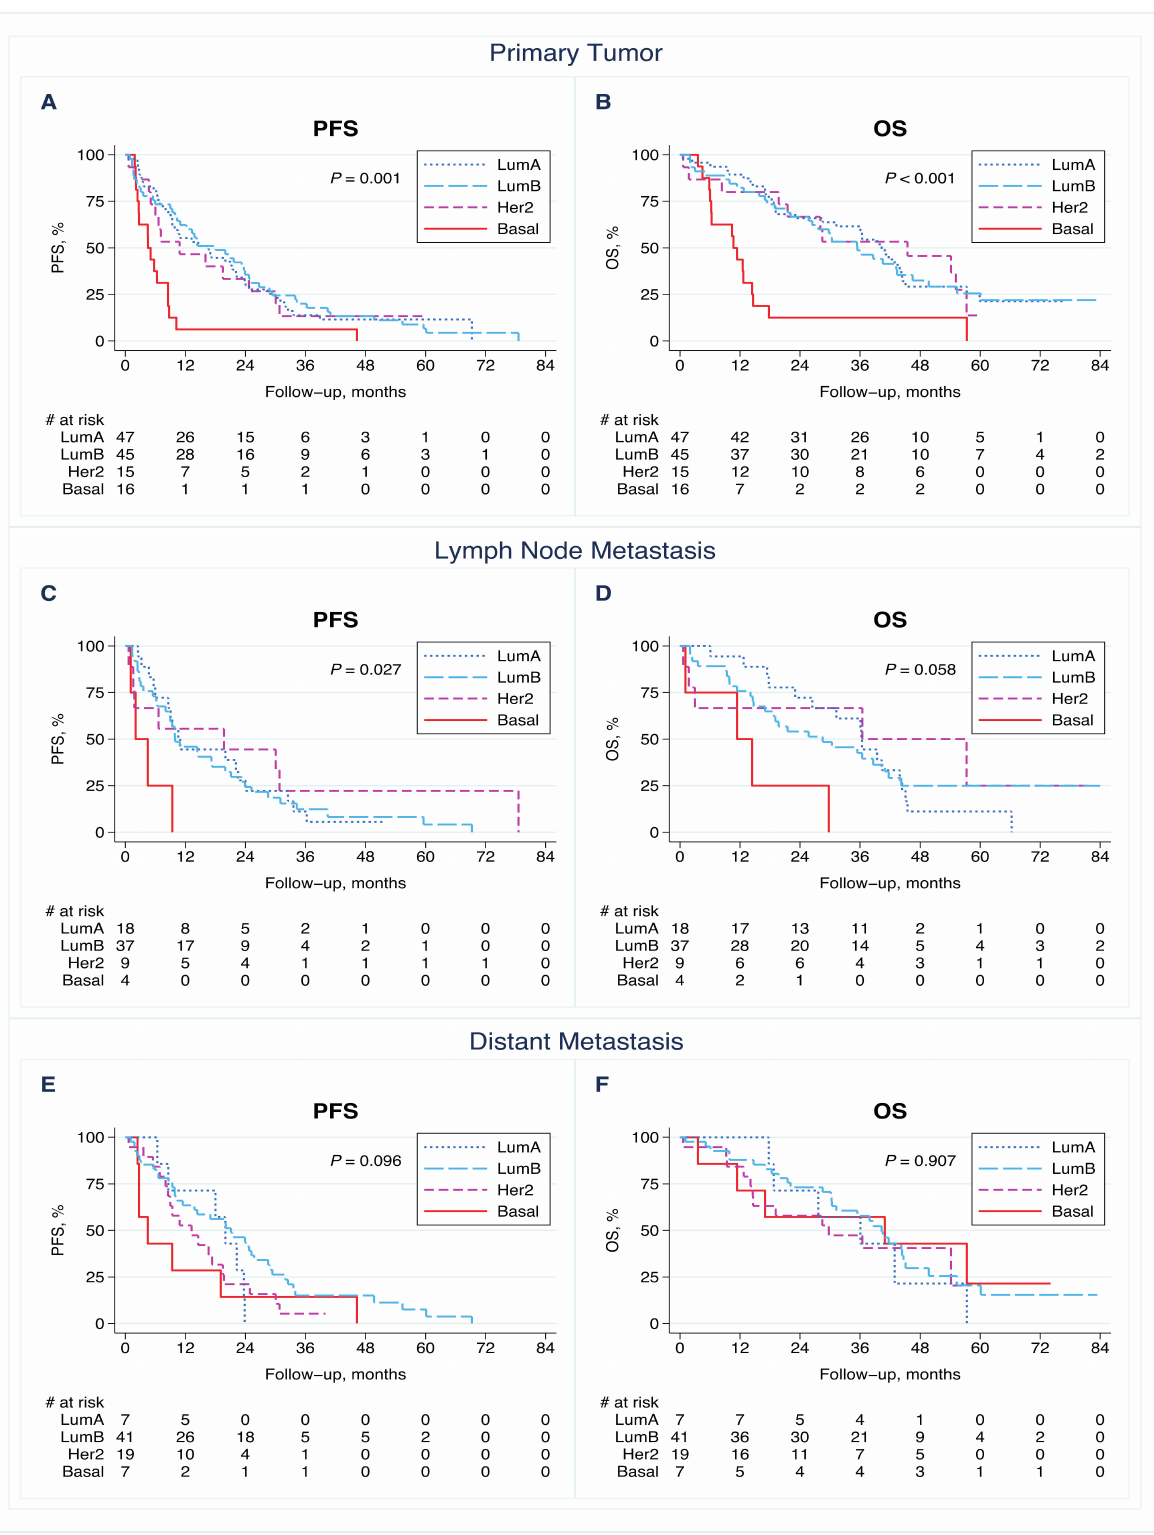
Figure 3. Kaplan–Meier survival curves for progression-free survival (PFS) and overall survival (OS) according to PAM50 breast cancer intrinsic subtype in the primary tumor ( A , B ), lymph node metastasis ( C , D ), and distant metastasis ( E , F ). p -values were calculated using the log-rank test. Abbreviations: HER2: human epidermal growth factor receptor 2; Lum A/B: luminal